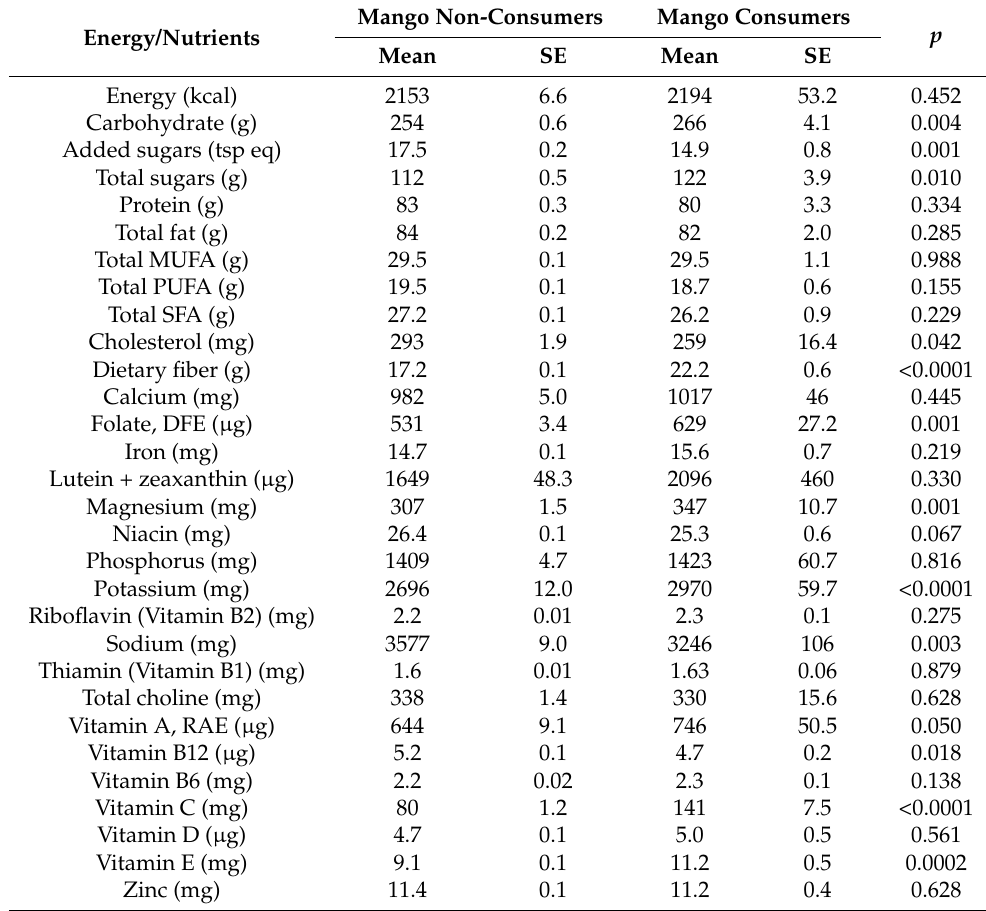
Table 3. Day 1 nutrient and energy intakes in mango non-consumers vs. mango consumers: adults aged 19+ years